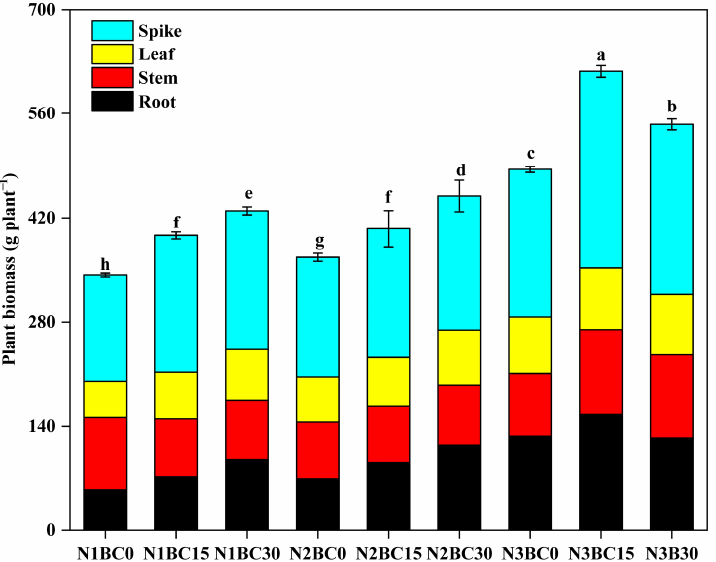
Figure 3. Dry weights of maize biomass with combined nitrogen fertilizer and biochar treatments. Vertical bars represent the standard deviation, SD, of the mean ( n = 4); different letters on the SD bars indicate significant differences among the nitrogen fertilizer and biochar treatment groups ( p < 0.05). Table 4. Changes of maize grain yield with different nitrogen fertilizer and biochar treatments.